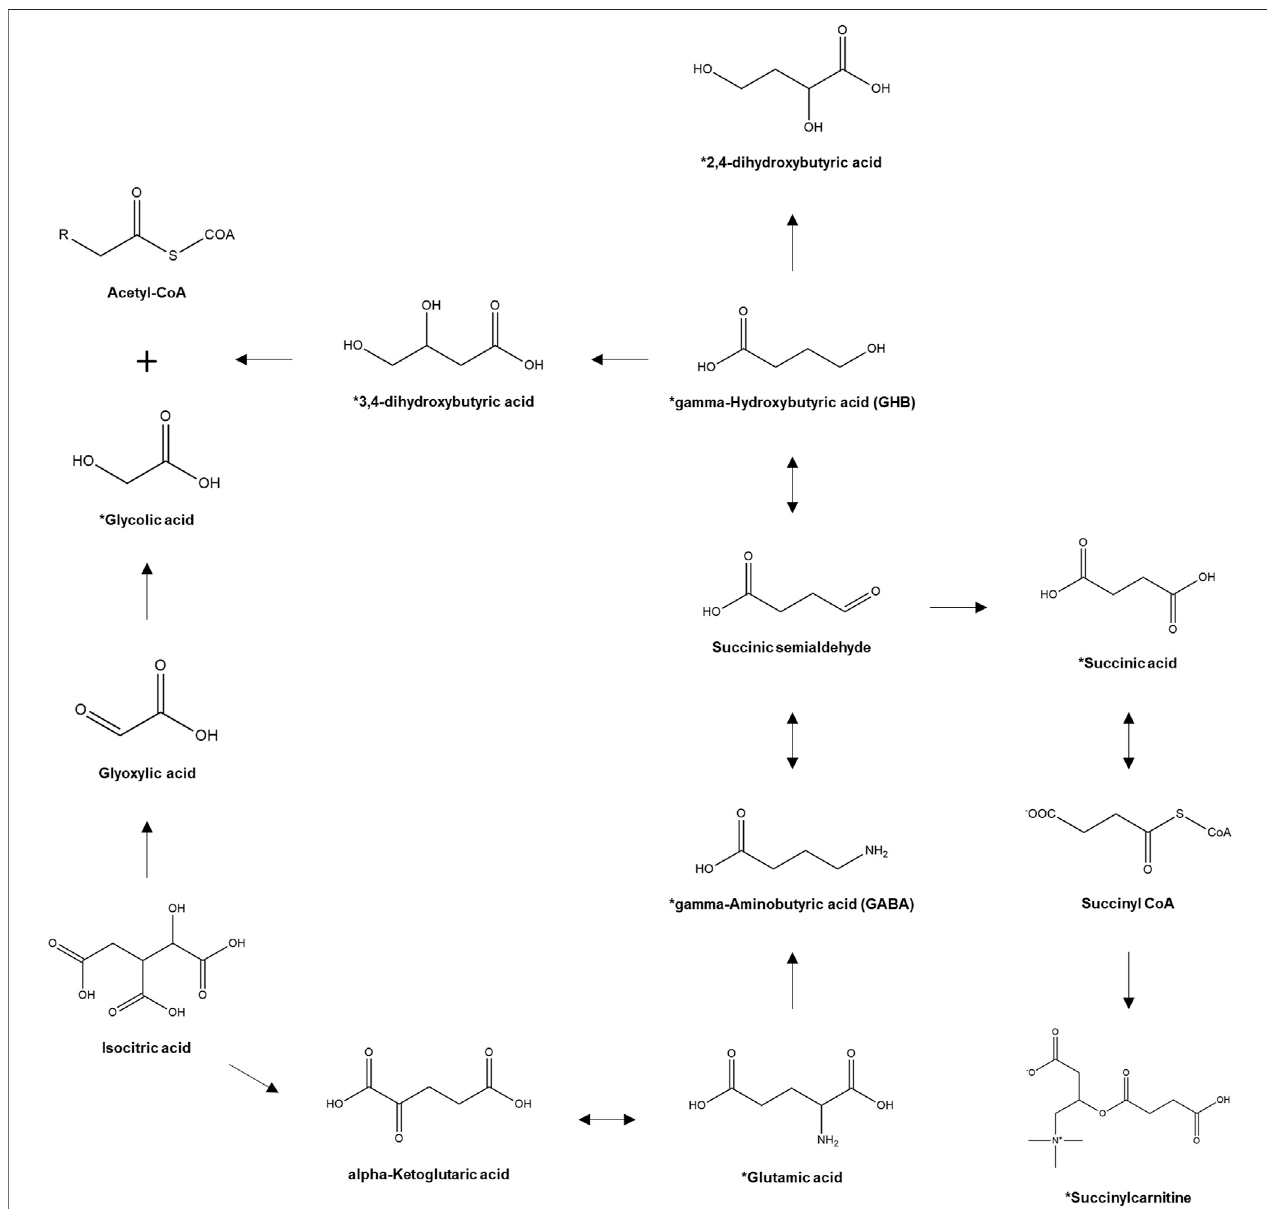
FIGURE 1 | Pathway of GHB biosynthesis and metabolism. *, target analytes. (Kim et al., 2022).